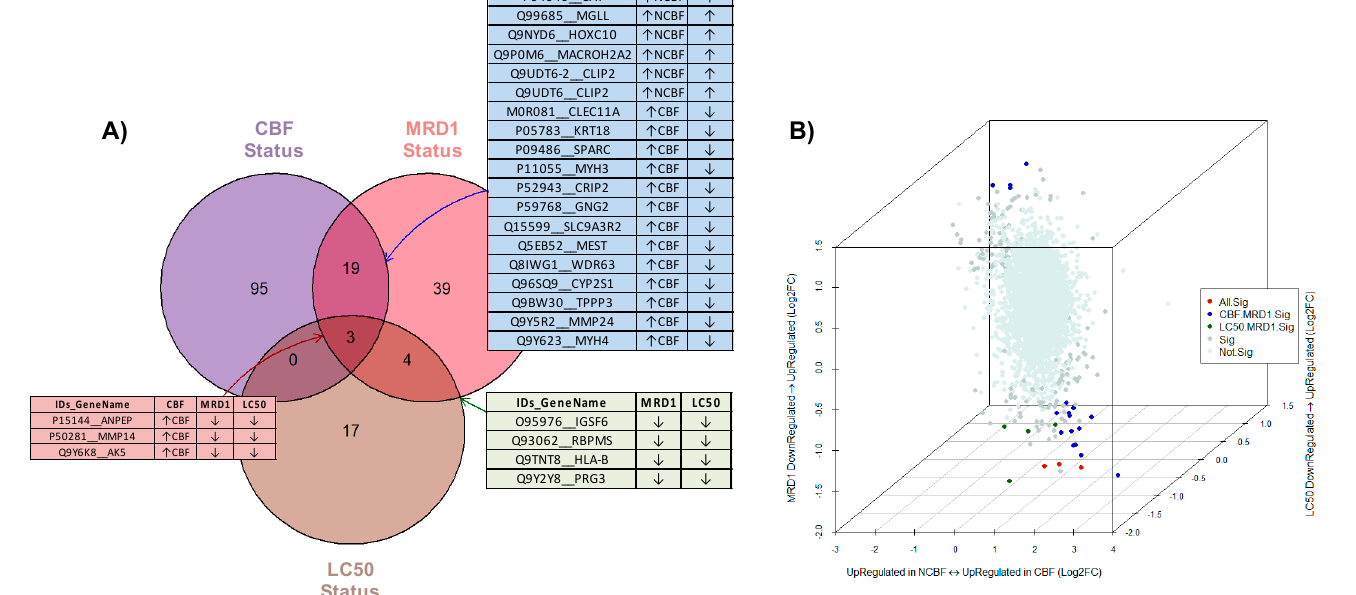
Figure 5. Integrative analysis of three differential comparisons (CBF, MRD1, and Ara-C LC50): ( A ) Venn diagram illustrating unique and overlapping significant DEPs between all comparisons ( n = 177). Purple circle, CBF AML versus non-CBF AML; Pink circle, MRD1-positive versus MRD1-negative; Brown circle, Ara-C LC50-high versus Ara-C LC50-low; ( B ) 3D scatterplot with log2FC of the three comparisons: x -axis is the log2FC of CBF status with bidirectional, where positive values are upregulated in CBF and negative values are upregulated in non-CBF; y -axis is the log2FC of Ara-C LC50 (high vs. low); and z -axis is the log2FC of MRD1 (positive vs. negative). Red proteins in ( A ) table and dots are common significant proteins among three comparisons, blue proteins in ( A ) table and dots are significant proteins between CBF and MRD1 status, and green proteins in ( A ) table and dots are significant proteins between Ara-C LC50 and MRD1 status.